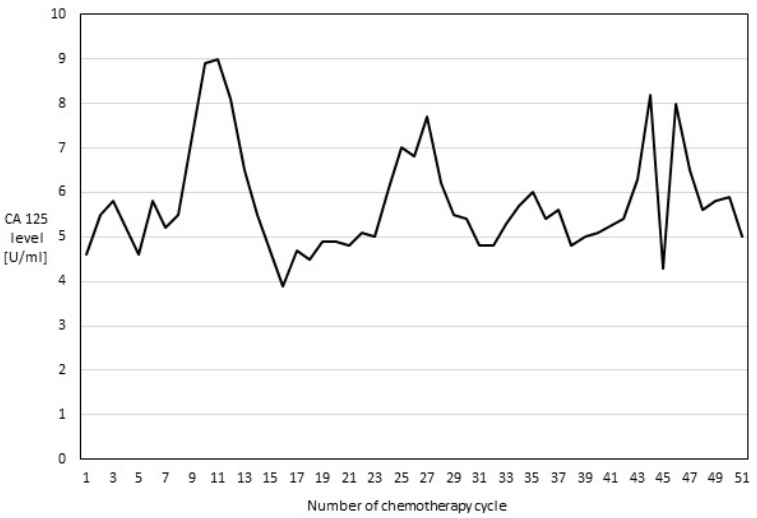
Figure 1. CA125 level in relation to olaparib chemotherapy cycle.